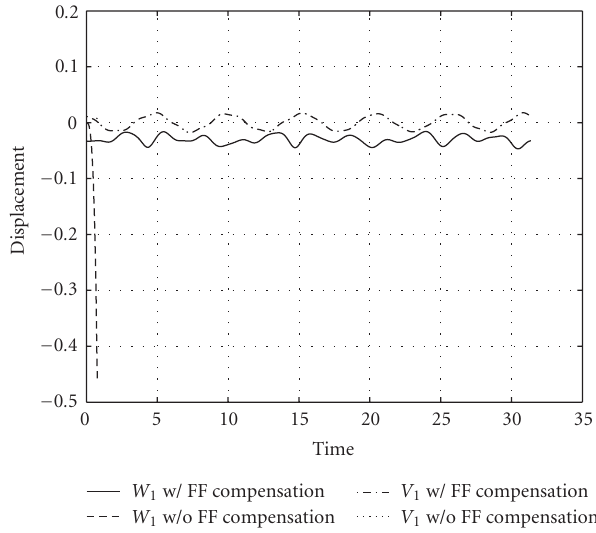
Figure 4: E ff ect of optimal FF controller for Ω b = 0 .